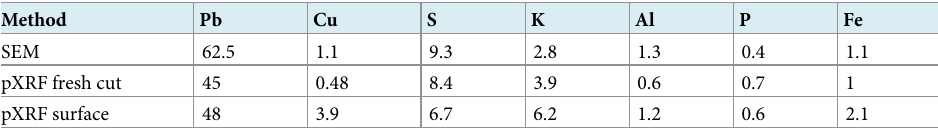
Table 4. Comparison of SEM and pXRF data for the lump Bleje ş ti 1–2. Method Pb Cu S K Al P Fe SEM 62.5 1.1 pXRF fresh cut 45 0.48 pXRF surface 2.1 Mean values in wt% (for discussion see